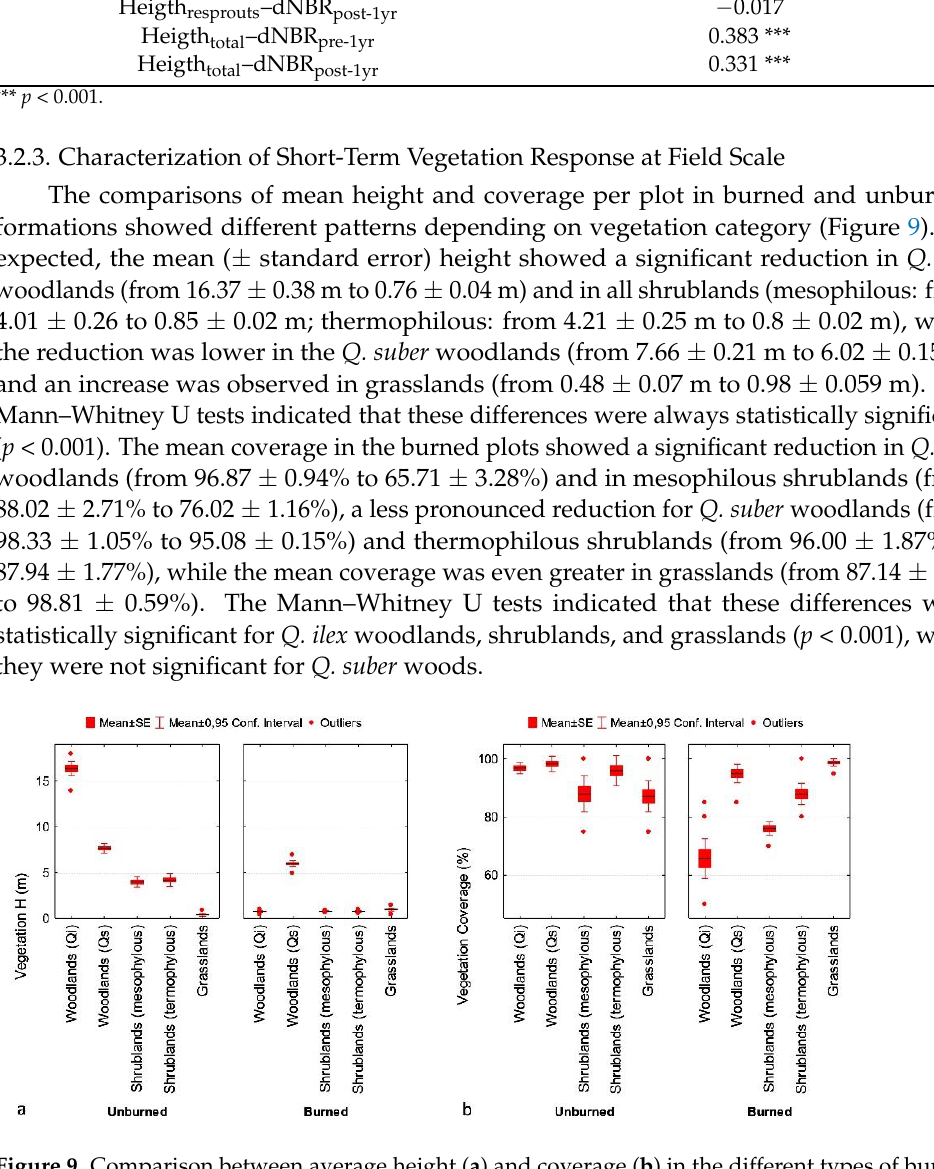
Figure 9. Comparison between average height ( a ) and coverage ( b ) in the different types of burned and unburned